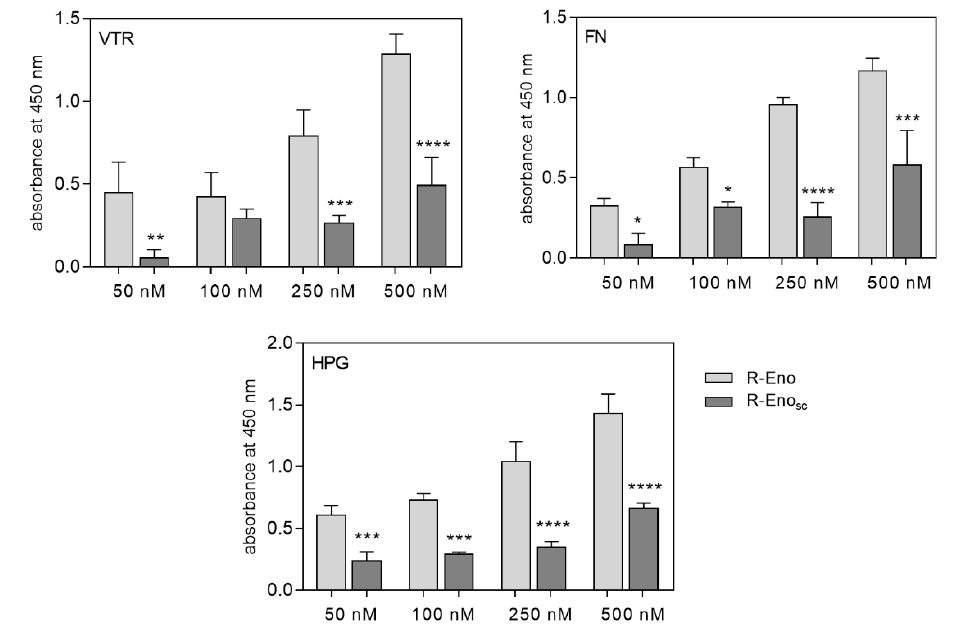
Figure 9. Binding of biotin-labeled recombinant fungal enolase to microplate-immobilized VTR, FN and HPG. Microplate wells coated with 3 pmoles of VTR, FN or HPG were filled with 50 µ L of biotin-labeled recombinant enolases in increasing concentrations. The absorbance intensities were measured after the washing of unbound proteins. The results obtained during the control experiment (non-human protein surface blocked with 3% BSA solution) were subtracted from the total binding measurements. The bars represent the mean values ± standard deviation (3 determinations). Statistical significance was determined using one-way ANOVA; * p < 0.05, ** p < 0.01, *** p < 0.001, **** p < 0.0001.